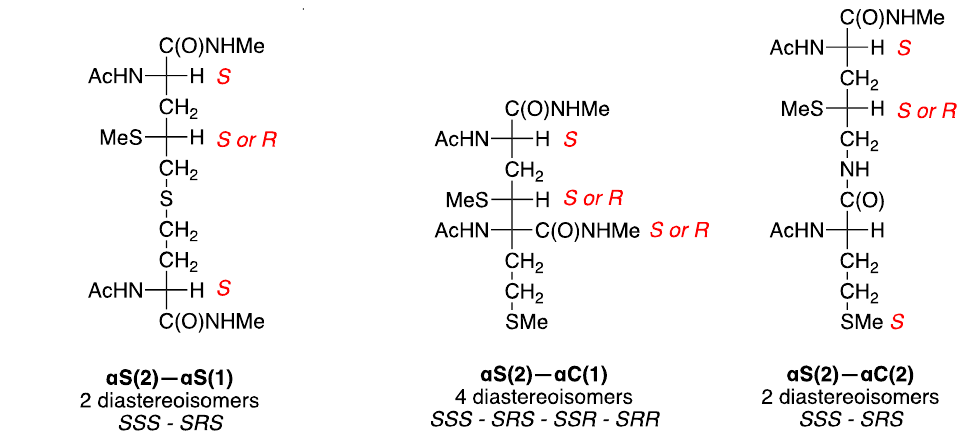
Figure 5. The chemical structures of αS(2)–αS(2), αS(2)–αS(1) and αS(2)–αC(2) identified in the radiolysis study of starting material 2 ; the configuration of stereocenters are indicated in red.